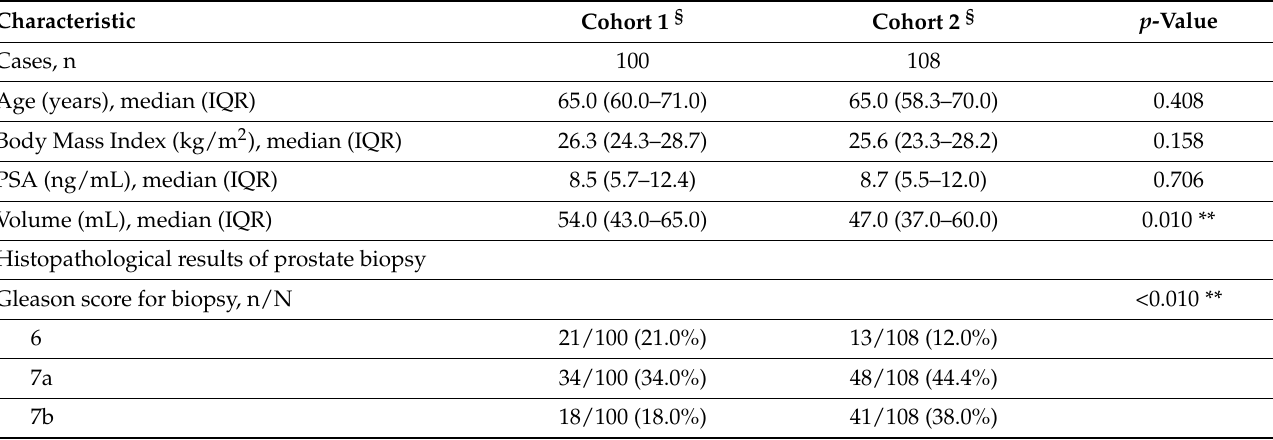
Table 1. Baseline